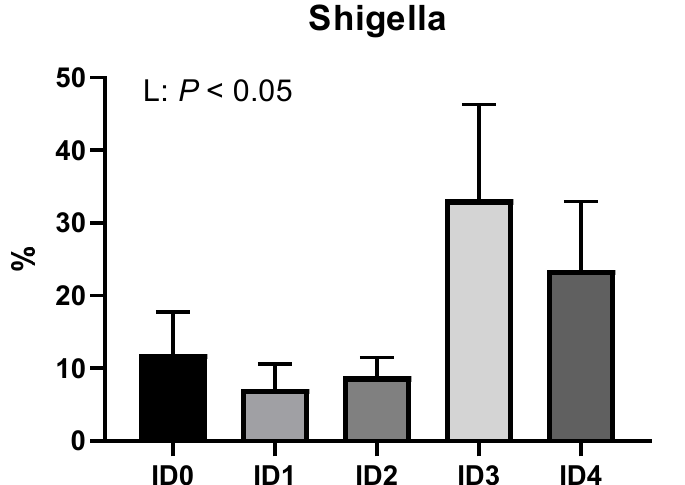
Figure 6. Effects of different infection doses of Eimeria tenella on relative abundance of genus Shigella in broilers 6 days post-infection. The relative abundance of genus Shigella was measured in the ID0 (infection dose 0; sham-challenged with phosphate-buffered saline); ID1 (infection dose 1; challenged with 6250 sporulated oocysts of Eimeria tenella ); ID2 (infection dose 2; challenged with 12,500 sporulated oocysts of E. tenella ); ID3 (infection dose 3; challenged with 25,000 sporulated oocysts of E. tenella ); ID4 (infection dose 4; challenged with 50,000 sporulated oocysts of E. tenella ) groups. Data were analyzed by using One-way ANOVA followed by the Tukey’s multiple comparison test. Orthogonal polynomial contrast analysis was used to assess linear (L) and quadratic (Q) effects of the infection doses, and p < 0.1 were presented.